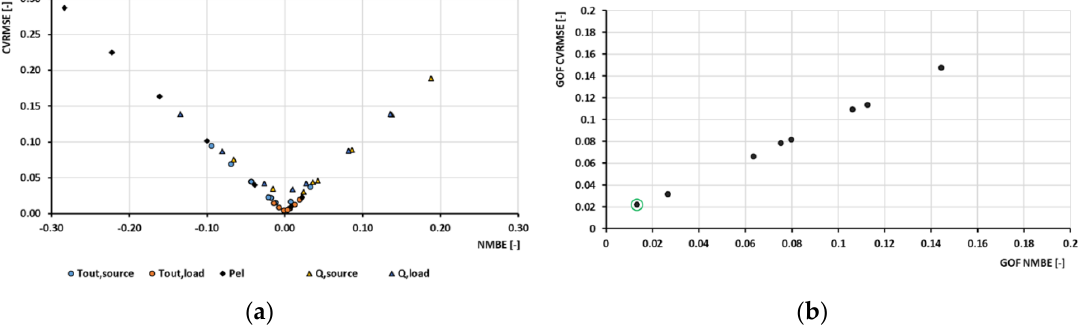
Figure 4. Results for the different variables considered for the water-source heat pump (WSHP) model calibration: ( a ) normalised mean bias error (NMBE) vs. coefficient of variation of the root mean square error ( CVRMSE) and ( b ) goodness of fit (GOF) NMBE vs. GOF CVRMSE.